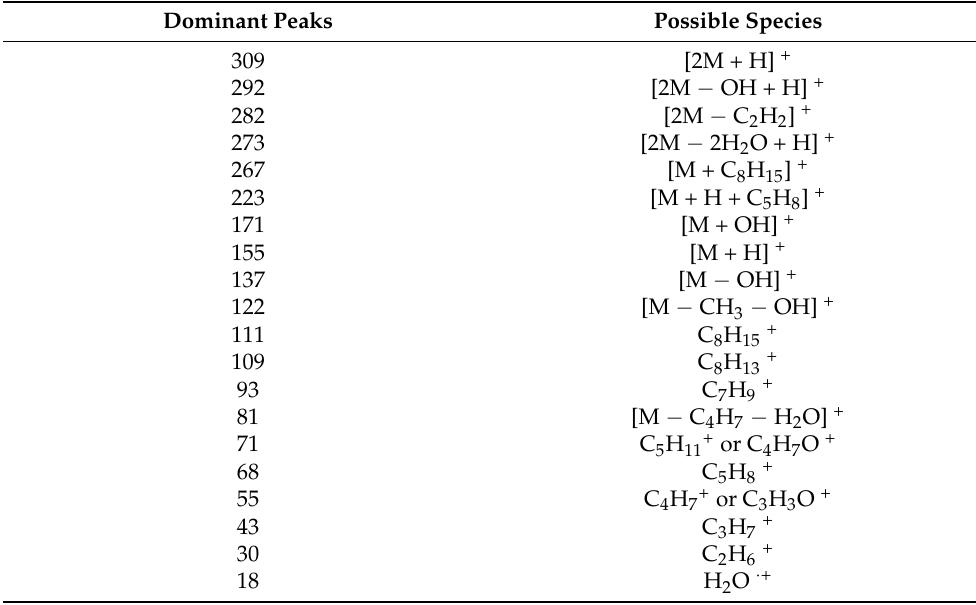
Table 4. Peak assignment in terpinen-4-ol PIM mass